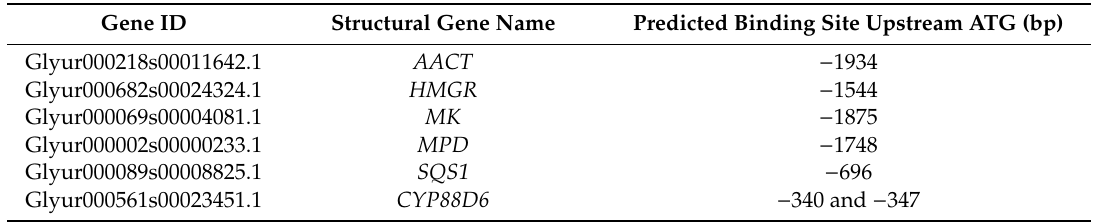
Table 2. Analysis of the R2R3-MYB binding